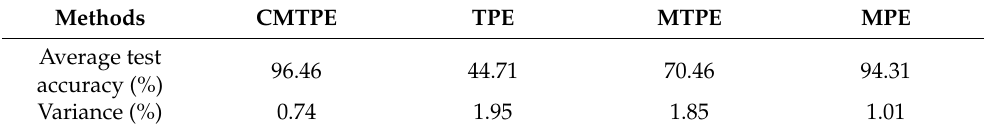
Table 3. Average test accuracy and variance of the four methods for different degrees of crack faults.